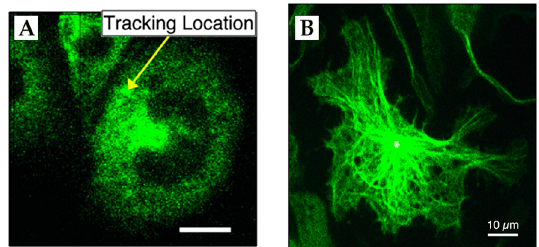
Figure 14. Tetrahedral detection tracking coupled with simultaneously acquired spinning disk confocal images. ( A ) Localization of QD-labeled probe within the cellular structured using LED illumination requiring 300 ms exposure time. ( B ) Laser excitation reduced needed exposure time to 40 ms and provides a much higher contrast image than ( A ). Reprinted from reference [102], with the permission of AIP Publishing.